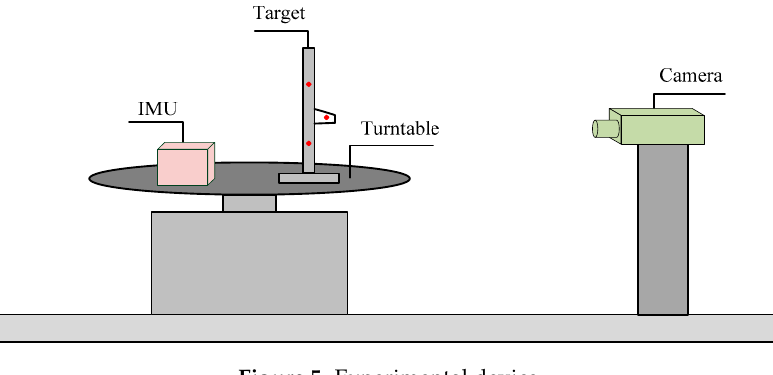
Figure 5. Experimental device. Table 1. Gyroscope